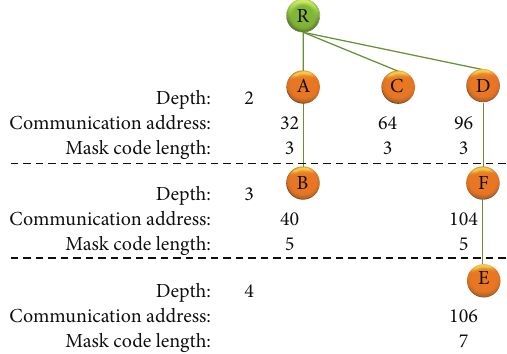
Figure 10: Node information of RPs in the TAN.